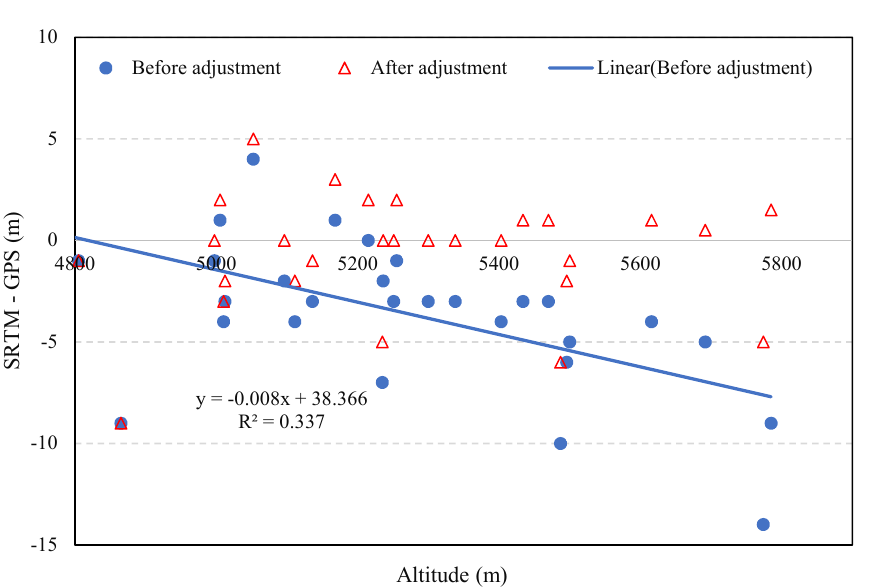
Figure 3. Elevation differences between SRTM band and GPS as a function of altitude before and after adjustment.